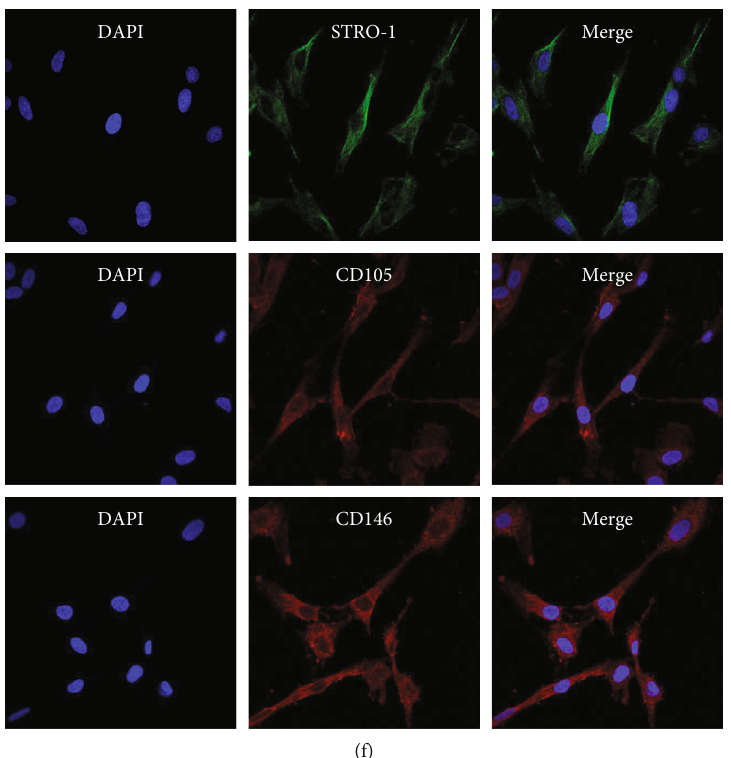
Figure 1: Culture and identi fi cation of dental pulp stem cells (DPSCs). (a) Morphology of primary DPSCs at day 5. (b) Colony-forming DPSCs obtained by limiting dilution assay. (c) Alizarin red staining of cells after odonto/osteogenic induction for 14 days. (d) Oil red O staining of cells after adipogenic induction for 21 days. (e) Flow cytometric analysis demonstrated that cells were negative for CD34 and CD45, but positive for CD29, CD90, CD105, CD146, and STRO-1. Cells incubated with IgG-PE were served as isotype control. (f) Immuno fl uorescence staining displayed positive expression of mesenchymal stem cells surface antigens STRO-1, CD105, and CD146. Nuclei were counterstained with DAPI. Scale bar =200 μ m (a, c); 100 μ m (b, d); 50 μ m